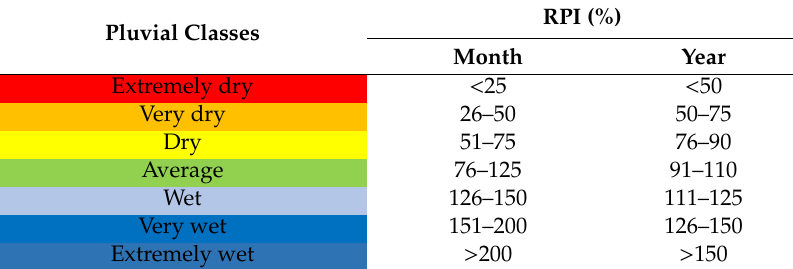
Table 2. Pluvial classification on the basis of relative precipitation index